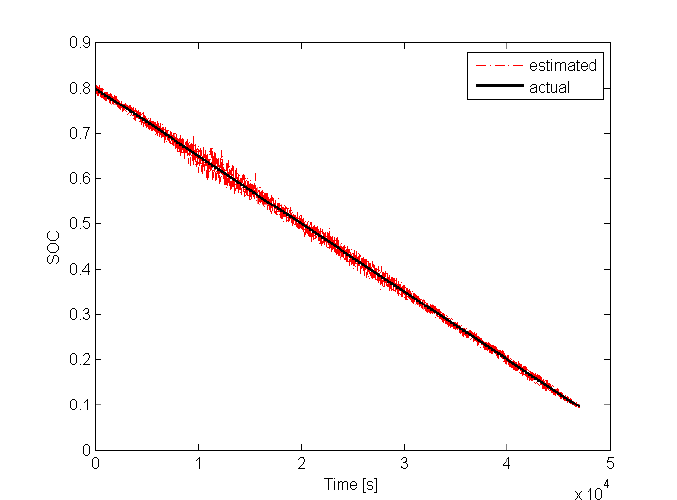
Figure 11. Actual SOC and its estimate.